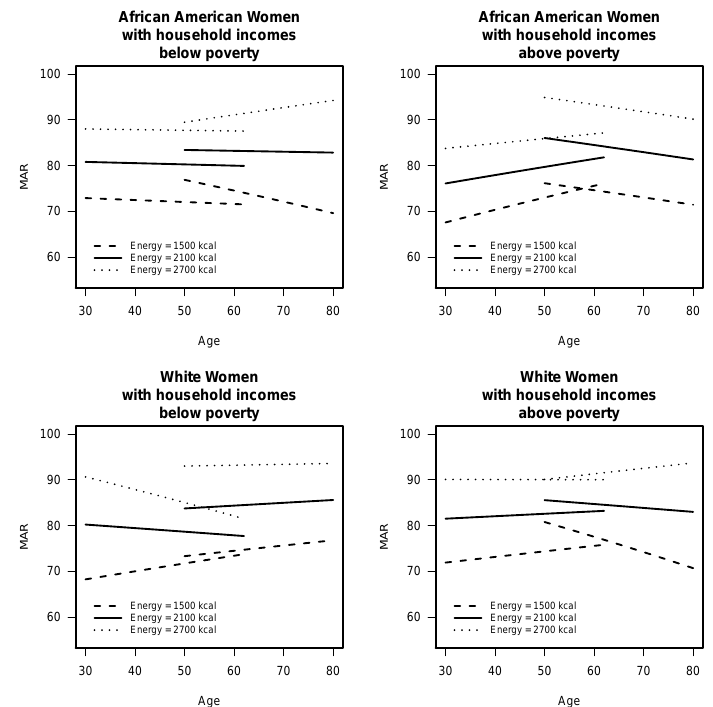
Figure 3. Mean Adequacy Ratio (MAR) scores across baseline and waves 3 and 4 of HANDLS study for women by initial age cohort ( < 50 or ≥ 50 years at baseline,) and by poverty ( < 125% or > 125% poverty threshold) for three levels of energy intake. HANDLS-Healthy Aging in Neighborhoods of Diversity across the Life